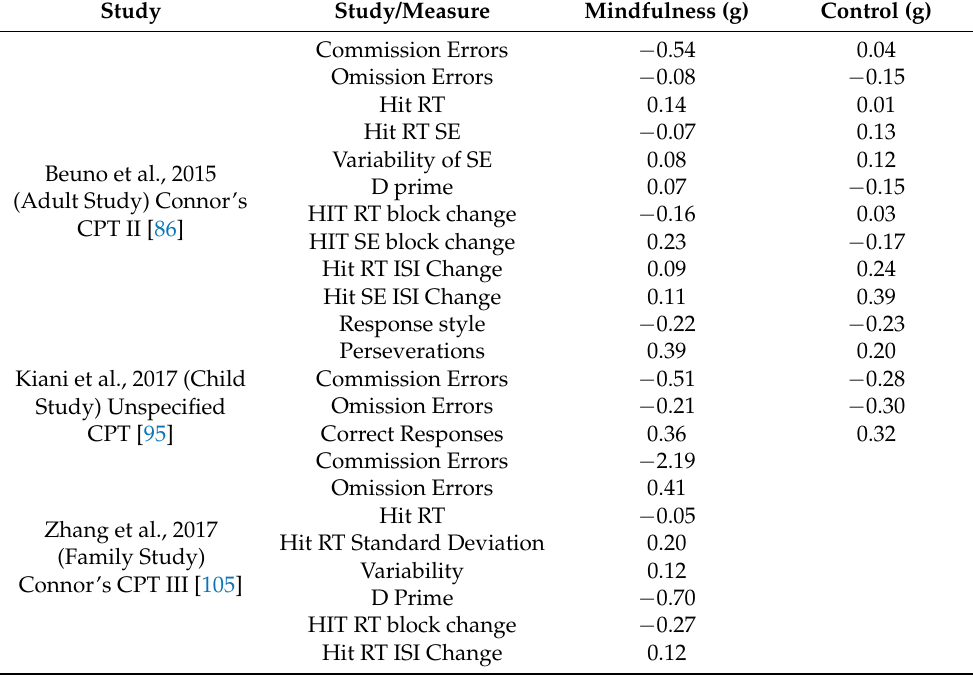
Table 3. Effect sizes for different measures within the Continuous Performance Task (CPT) collected in adults and children with ADHD. RT = Reaction Time, SE = Standard Error, ISI = Interstimulus